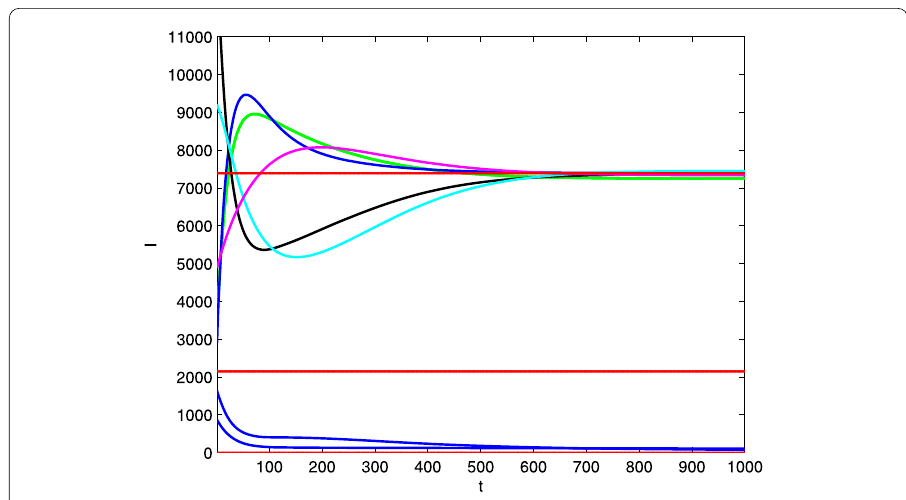
Figure 8 The trajectories of infected psyllid in (2.1) with α = 0.85 for different selection of initial values.